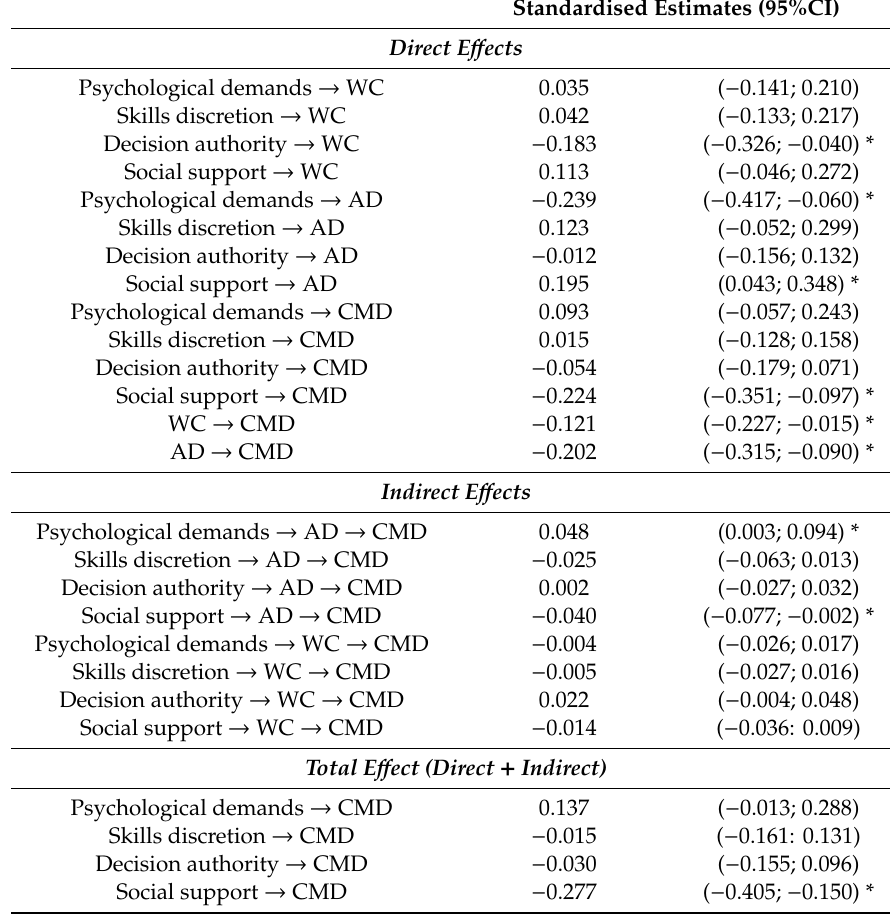
Table 3. Associations between psychosocial aspects of work, work impaired by presenteeism and common mental disorders, among presenteeists nursing personnel ( n = 400)—Brazil,